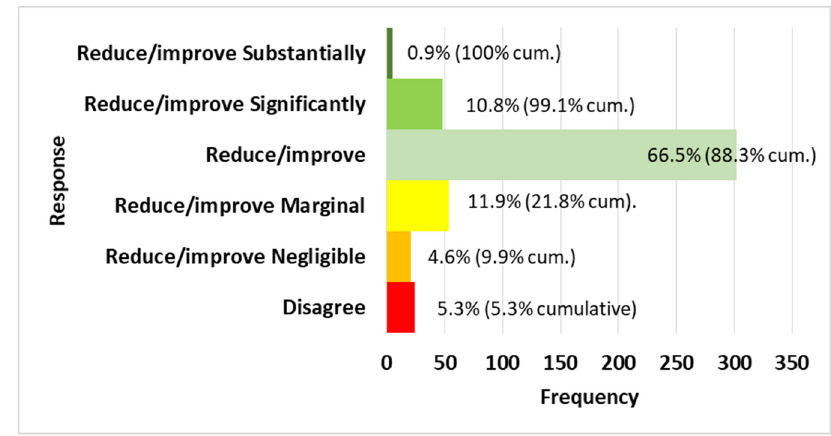
Figure 7. For each level of cost of water benefit (y-axis), the frequency of responses (x-axis), aggregated across all cost of water benefits.